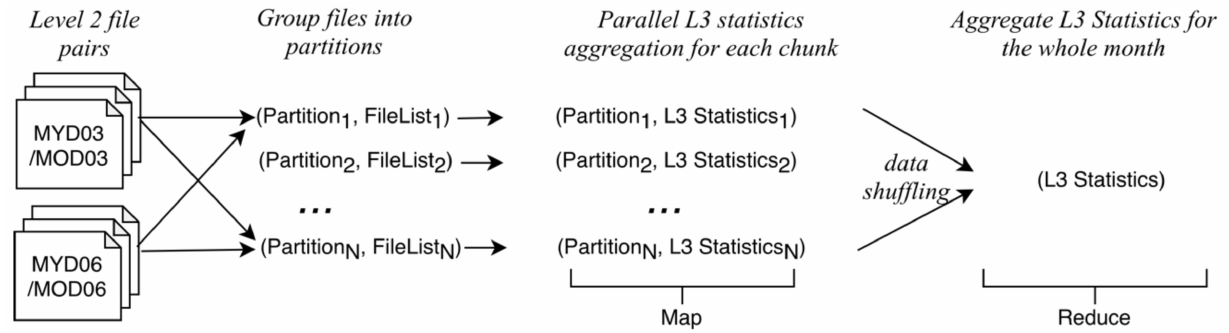
Figure 1. Illustration of data partitioning-based parallel aggregation with one-month